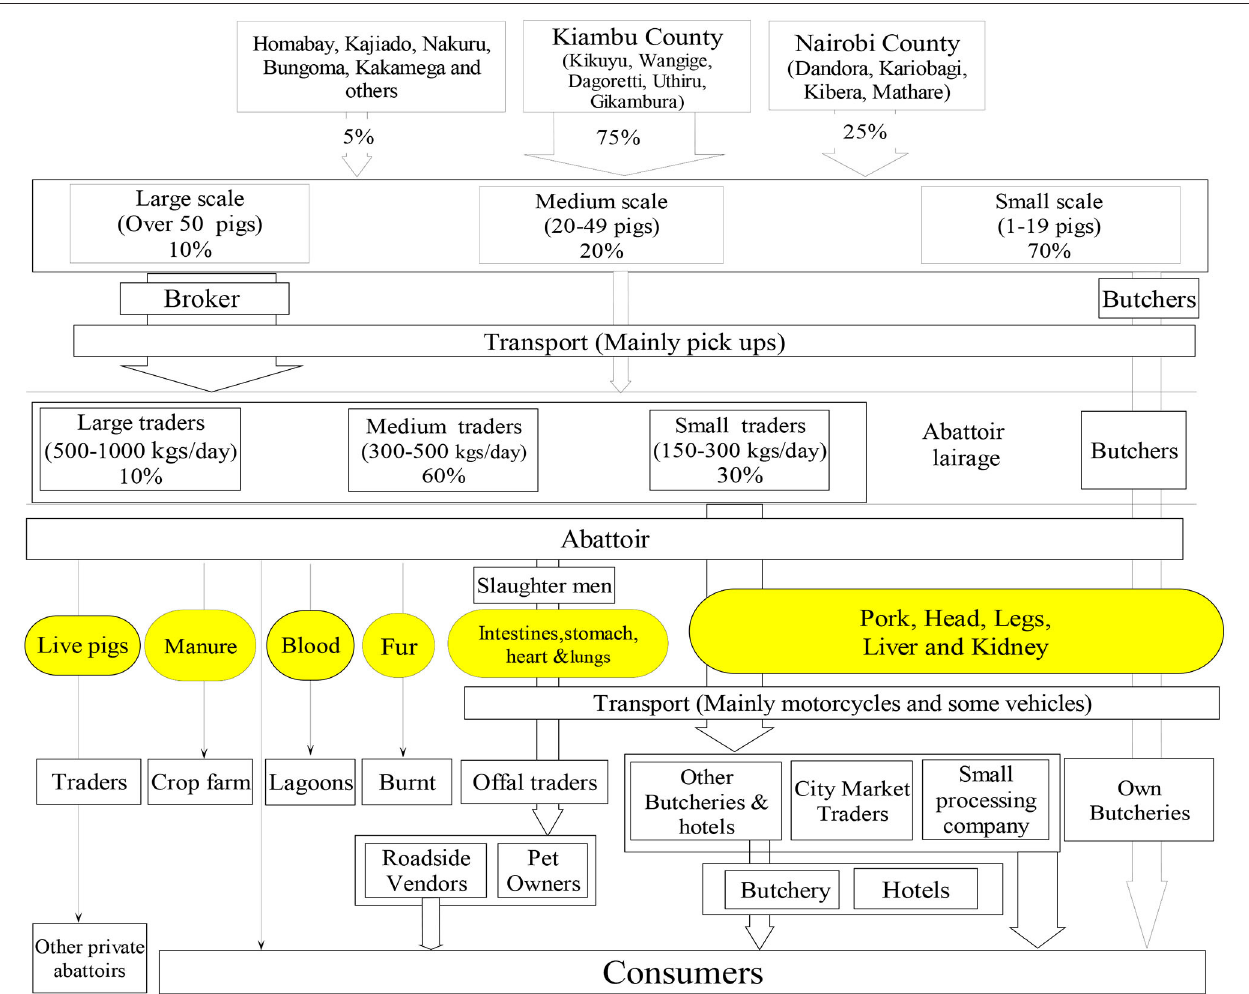
(i) Live pigs trading: While in abattoirs A and B, no trading of live pigs was reported in the lairage, in abattoir C, farmers were able to bring pigs in the lairage and sell them to either traders, brokers, butchers or other farmers.